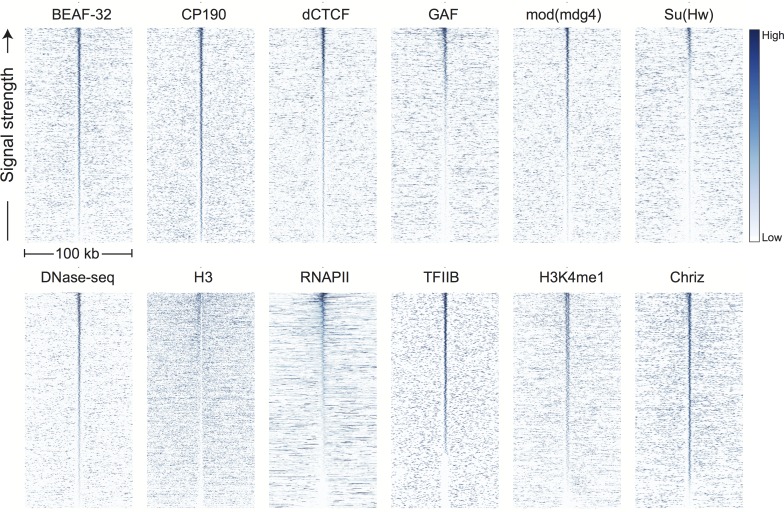
Genomic signals around topological boundaries, self-sorted.Data were prepared and displayed identically to Figure 3 except that each plot is sorted high-to-low by the sum of its own signal in the middle 10 bins (5 kb).